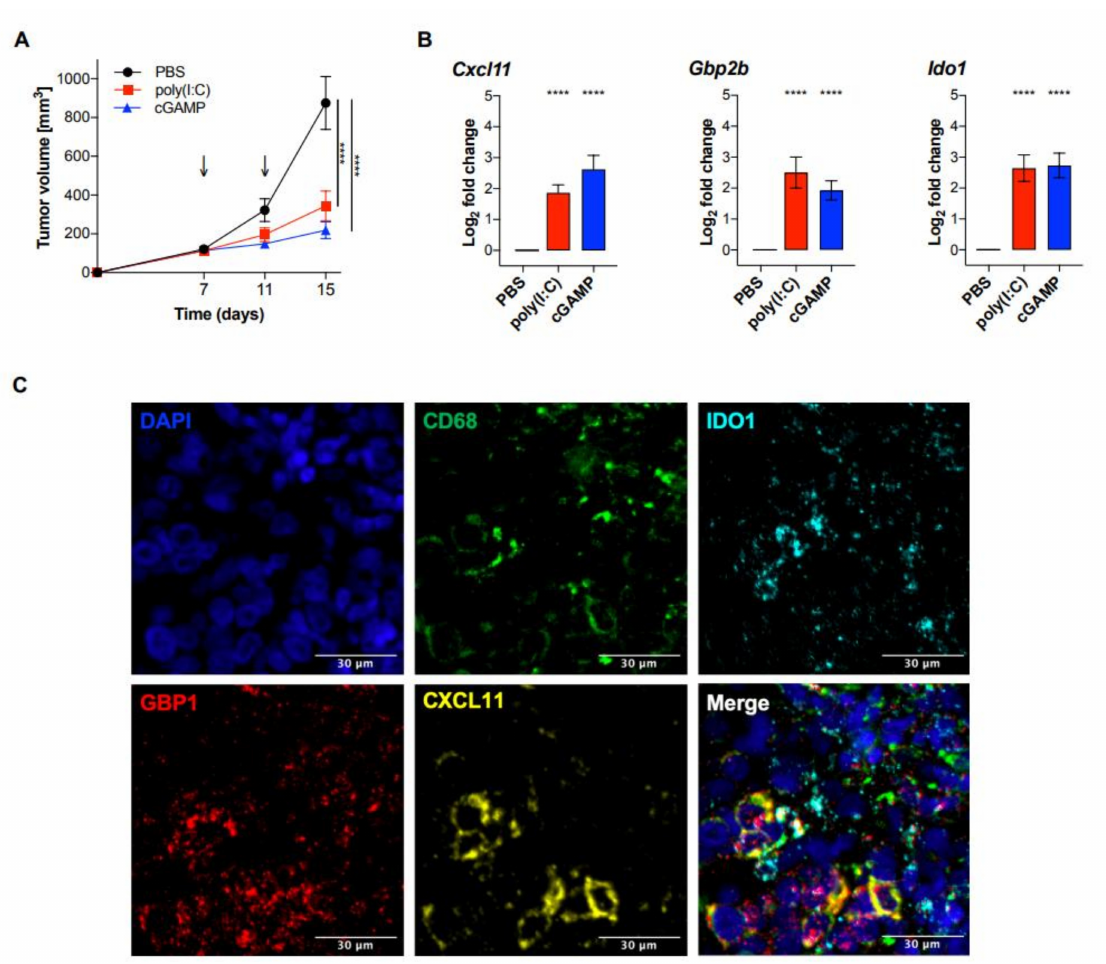
Figure 5. Intratumoral poly(I:C) and cGAMP significantly reduced tumor growth and induced the expression of the MA signature genes in vivo. C57BL / 6J wt mice were injected with 2 × 10 5 B16F10 melanoma cells and treated with poly(I:C) (50 µ g / mouse), cGAMP in lipofectamine (10 µ g / mouse), or PBS on day 7 and 11 after tumor injection. ( A ) Tumor size was measured using a caliper and tumor volume was calculated using the following formula: V = (length × width 2 ) / 2 ( n = 12 per group). Statistical significance was calculated by a two-way ANOVA followed by Šid á k’s multiple comparisons test. Data are represented as mean ± SEM and the p values are indicated as follows: p > 0.05 (ns), p ≤ 0.05 (*), p ≤ 0.01 (**), p ≤ 0.001 (***), p ≤ 0.0001 (****). ( B ) On day 12, tumors were isolated and analyzed for the MA signature expression by qPCR. Data were normalized to the housekeeping gene Rplp0 and are represented as mean ± SE of log 2 transformed values ( n = 12 per group) [21]. Statistical analysis was performed using an unpaired, two-tailed Students t -tests, and the p values are indicated as follows: p > 0.05 (ns), p ≤ 0.05 (*), p ≤ 0.01 (**), p ≤ 0.001 (***), p ≤ 0.0001 (****). ( C ) Fluorescent detection of RNA transcripts in human melanoma tissue. FFPE tissue section was hybridized with Opal-labeled probes for CD68 (Opal 520), CXCL11 (Opal 570), GBP1 (Opal 620), and IDO1 (Opal 690). Nuclei were counterstained with DAPI (blue). Adjustment of brightness and color merging was performed using ImageJ. Scale bar = 30 µ